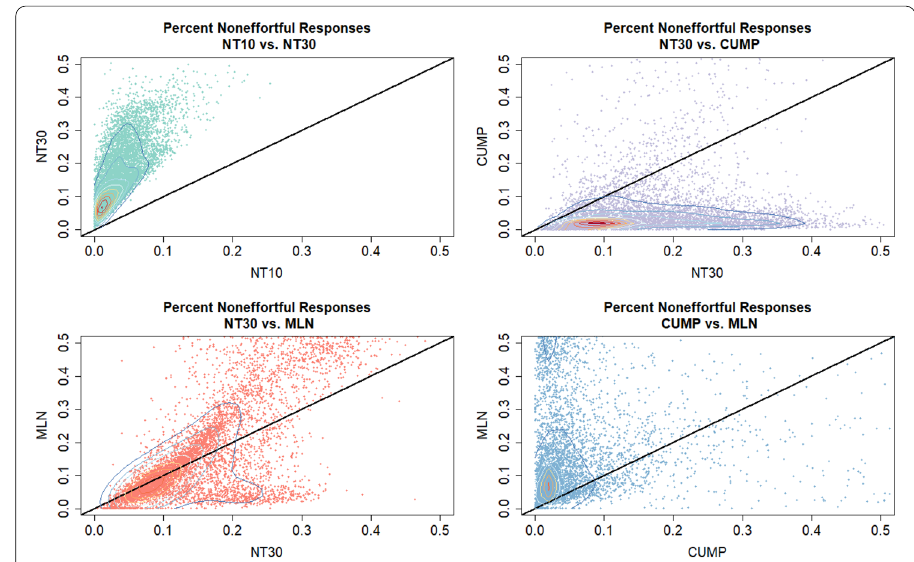
Fig. 3 Percent of item responses classified as noneffortful by threshold